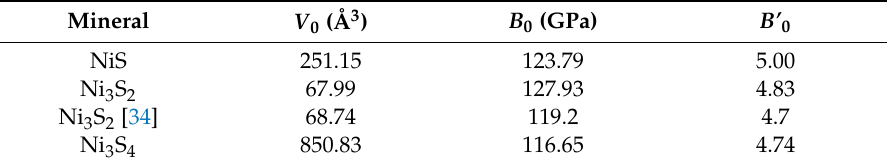
Table 2. Equation of state parameters of millerite, heazlewoodite, and polydymite.